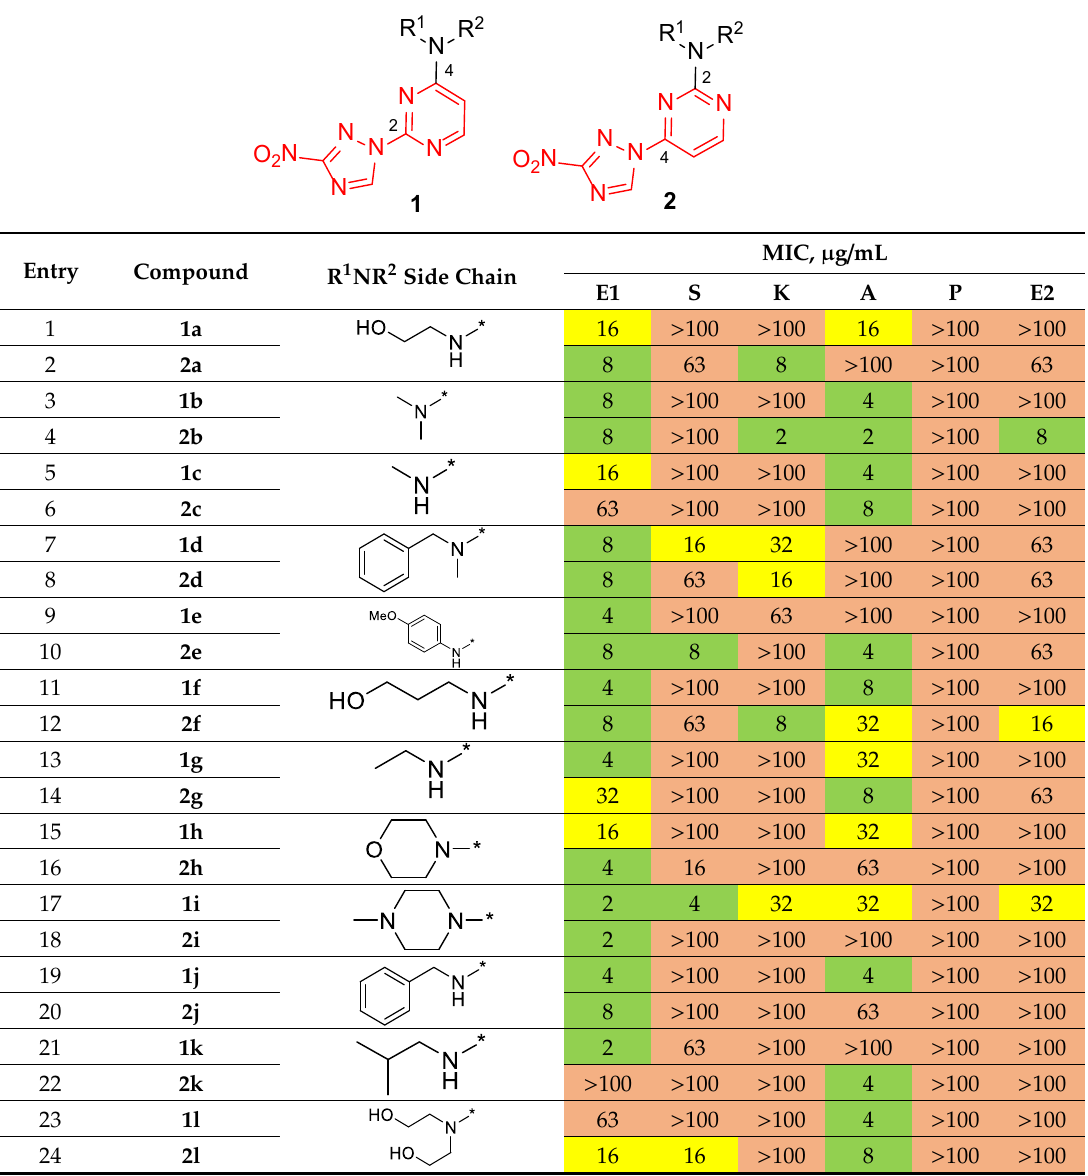
Figure 4. Single-crystal X-ray structures for compound 2h ( a , CCDC 1582450), 2k ( b , CCDC 1582440), 2n ( c , CCDC 1582442) and 2o ( d , CCDC 1582439); thermal ellipsoids are shown at 50% probability.